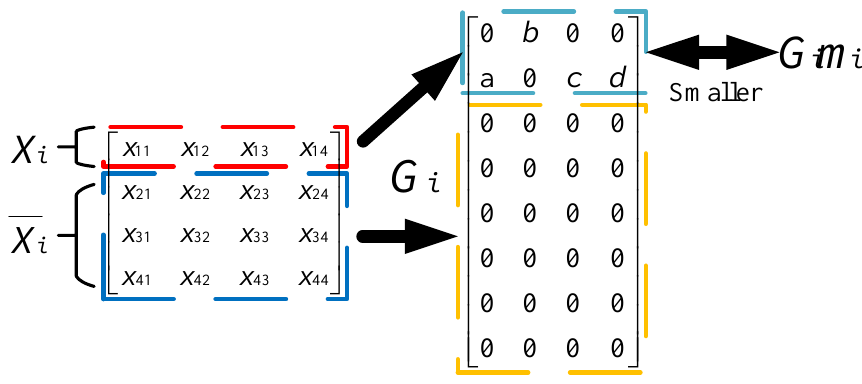
Figure 6. A schematic diagram of the new model.